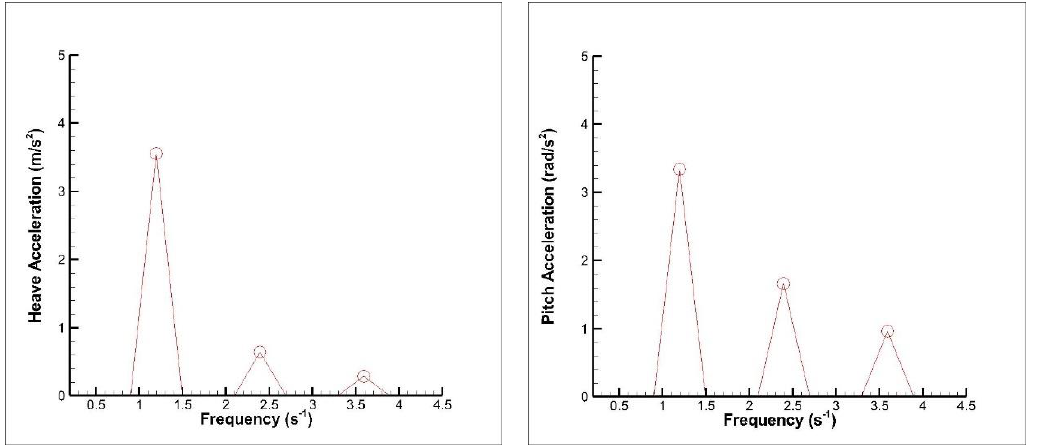
Figure 20. Time histories of heave ( left ) and pitch ( right ) accelerations for C8, Fn B = 2.82, warped hull.